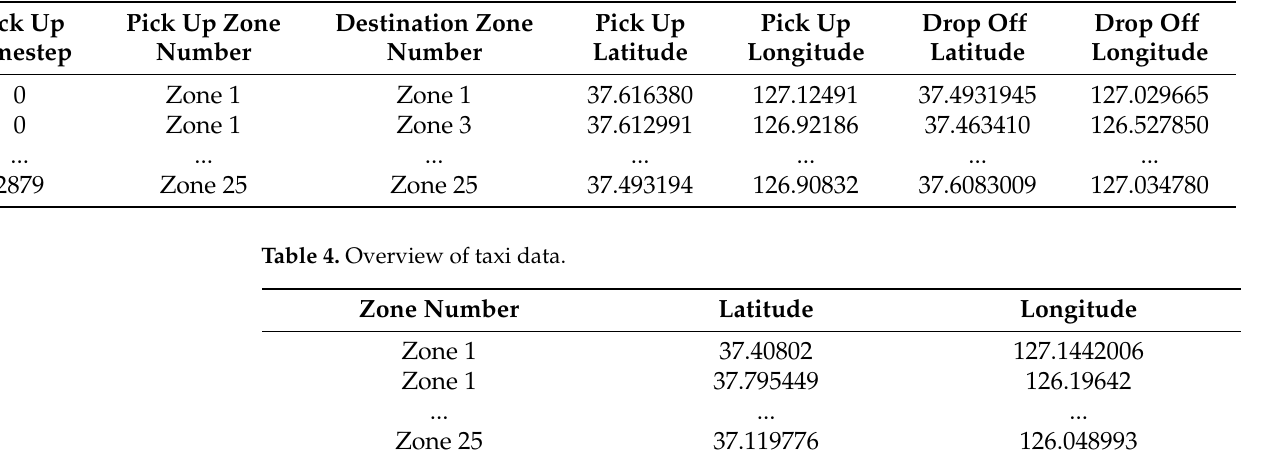
Table 3. Overview of order data.